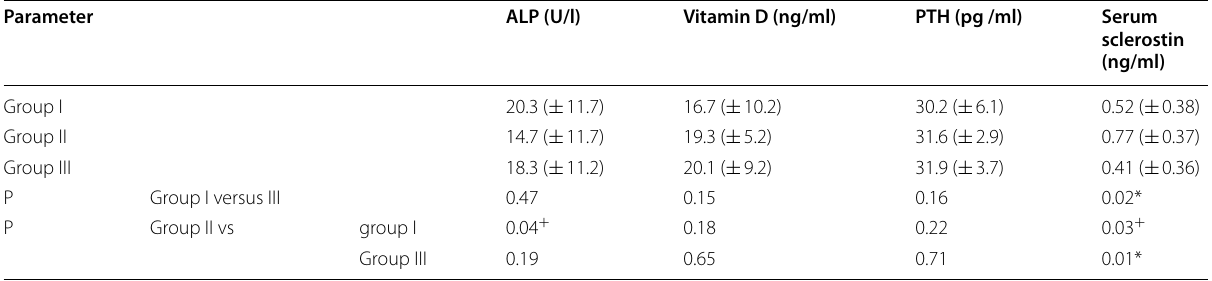
Table 3 Comparing bone remodeling parameters and serum sclerostin levels among all groups (I and II and III)